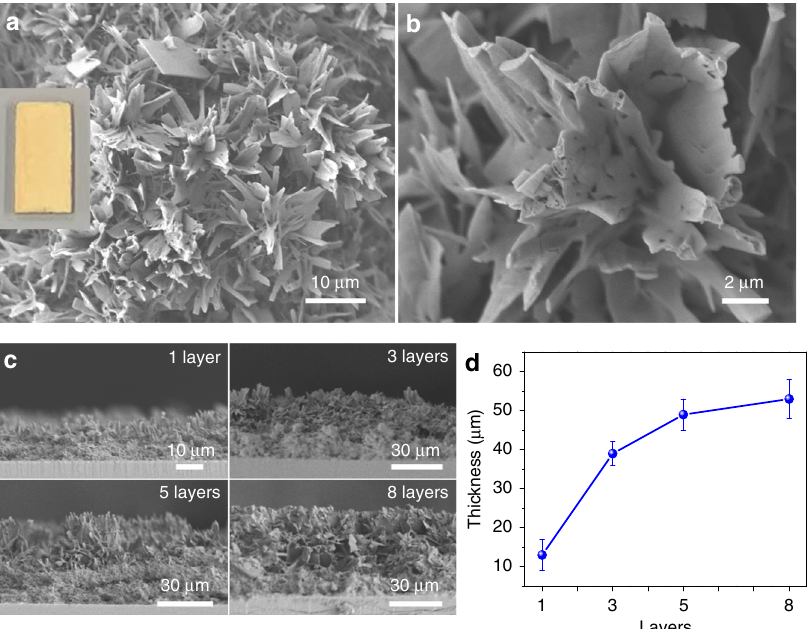
Fig. 2 CN T fi lm thickness control. a Top-view SEM image (inset: digital image of CN T /FTO electrode) and b magni fi ed top-view SEM image of CN T fi lm. c Cross-sectional SEM images of the different thicknesses CN T fi lms on FTO. d Relationship between the fi nal thickness of CN T fi lms and the corresponding thiourea layers. Each data point represents an average of three different CN T electrodes; error bars represent standard